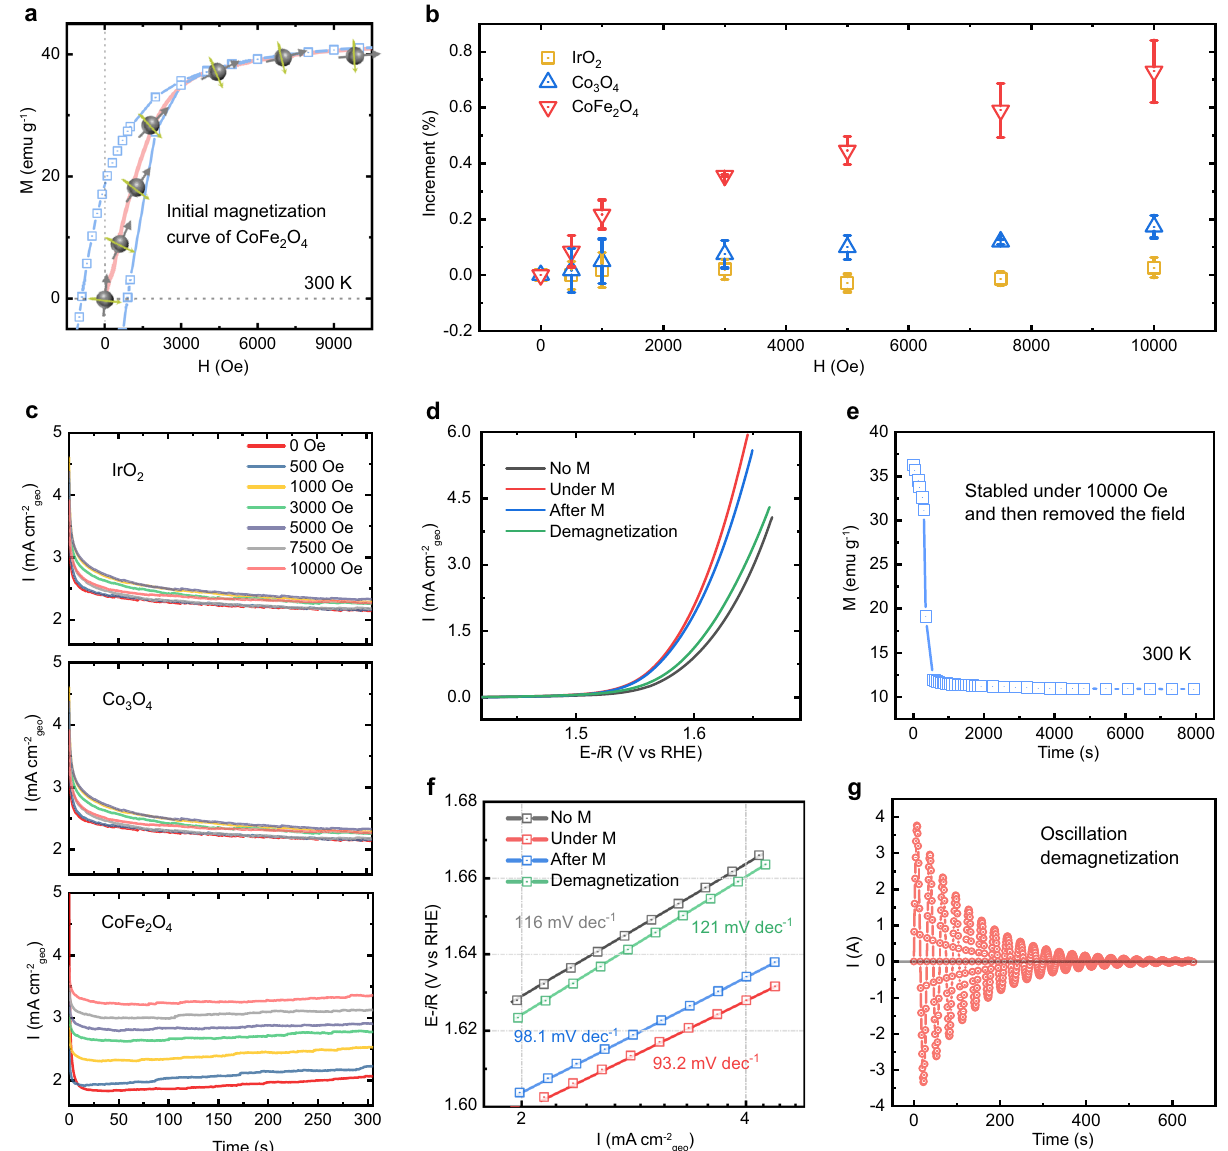
Fig. 6 The effect of gradient magnetic fi eld, remanence, and demagnetization. a Initial magnetization curve of CoFe 2 O 4 . b CA test in 1 M KOH under the different magnetic fi eld strength (0, 500, 1000, 3000, 5000, 7500, and 10000 Oe) at a constant potential of 1.66 V versus RHE for CoFe 2 O 4 , Co 3 O 4 , and 1.56 V versus RHE for IrO 2 . c The increment of the current density under different magnetic fi eld strength. It was calculated by the following equation: Increment (%) = ( j M – j M = 0 )/ j M = 0 ; j M is the chronopotentiometry current density values obtained under the applied magnetic fi elds (0, 500, 1000, 3000, 5000, 7500, and 10000 Oe). The error bar represents three independent tests. d LSV curves of CoFe 2 O 4 at a scan rate of 10 mV/s in O 2 -saturated 1 M KOH with and without a constant magnetic fi eld (10,000 Oe), after the magnetic fi eld removed (after M), and after demagnetization. The corresponding Tafel plots are shown in f . e The magnetization of CoFe 2 O 4 after removing a constant magnetic fi eld of 10,000 Oe. g The curve of demagnetization for CoFe 2 O 4